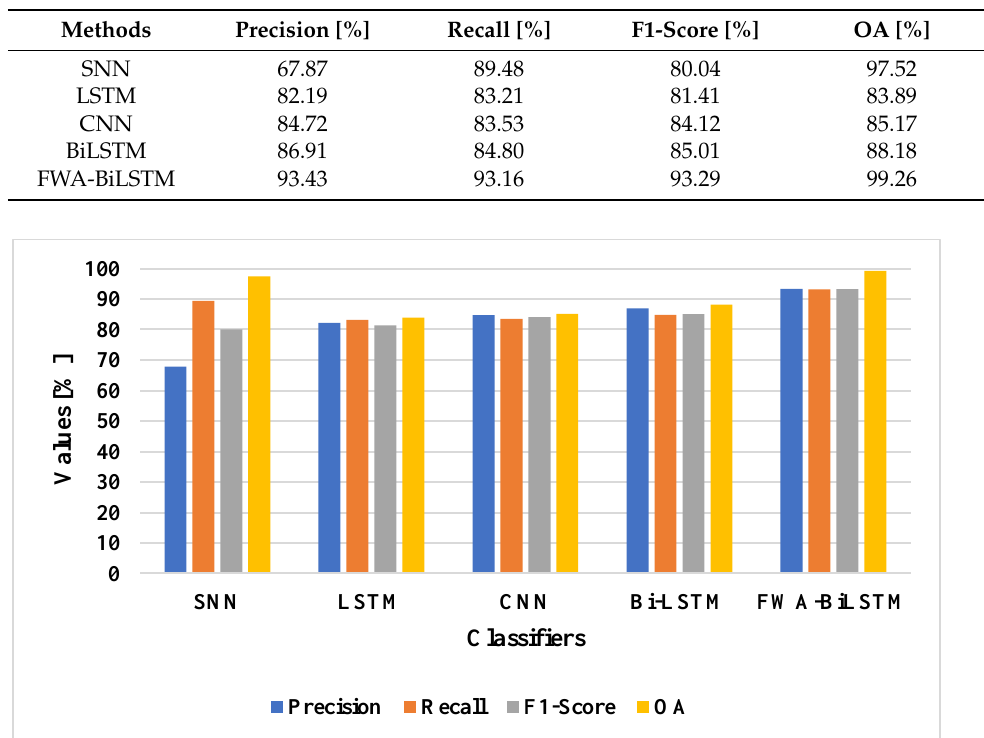
Table 3. Performance of classifier with attention layer on LEVIR-CD dataset.